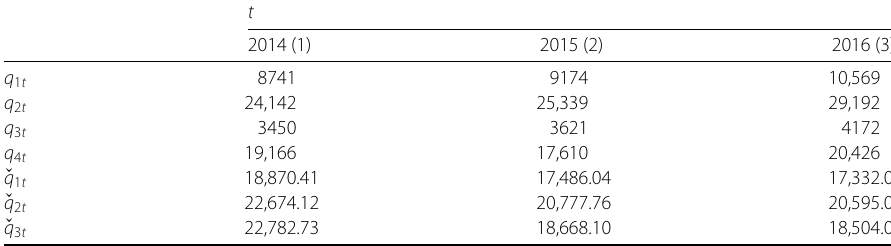
Table 3 Fixed and variable costs used in this instance Fixed cost